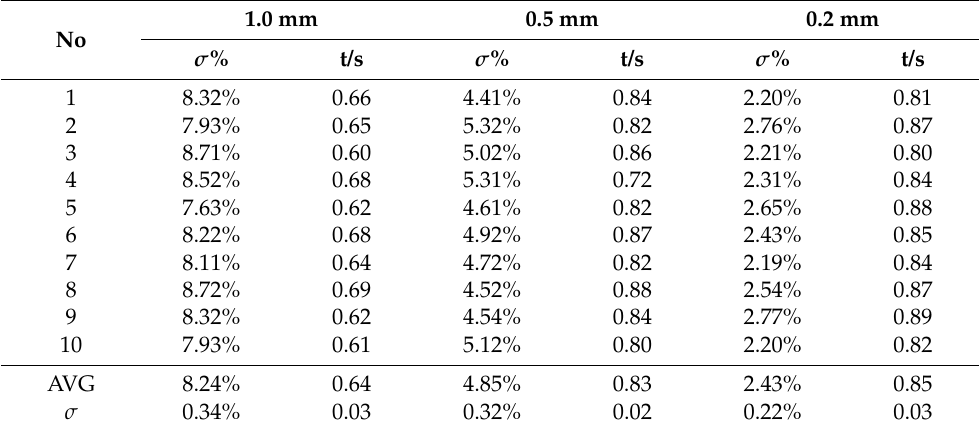
Table 3. Comparison of the dynamic characteristics of the repeatability test of ascending